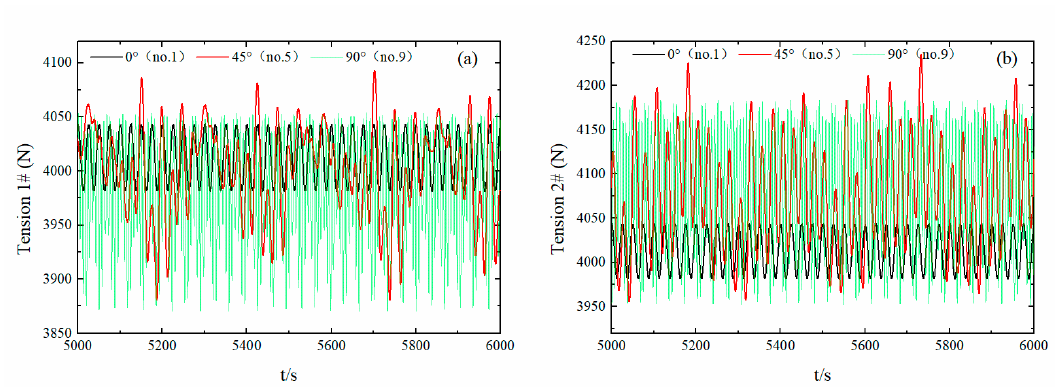
Figure 14. Time-history curves of the floating anchor chain tension with different wave angle directions. (Sub-figures: ( a ) time-history curves of anchor chain I tension; ( b ) time-history curves of anchor chain II tension.).